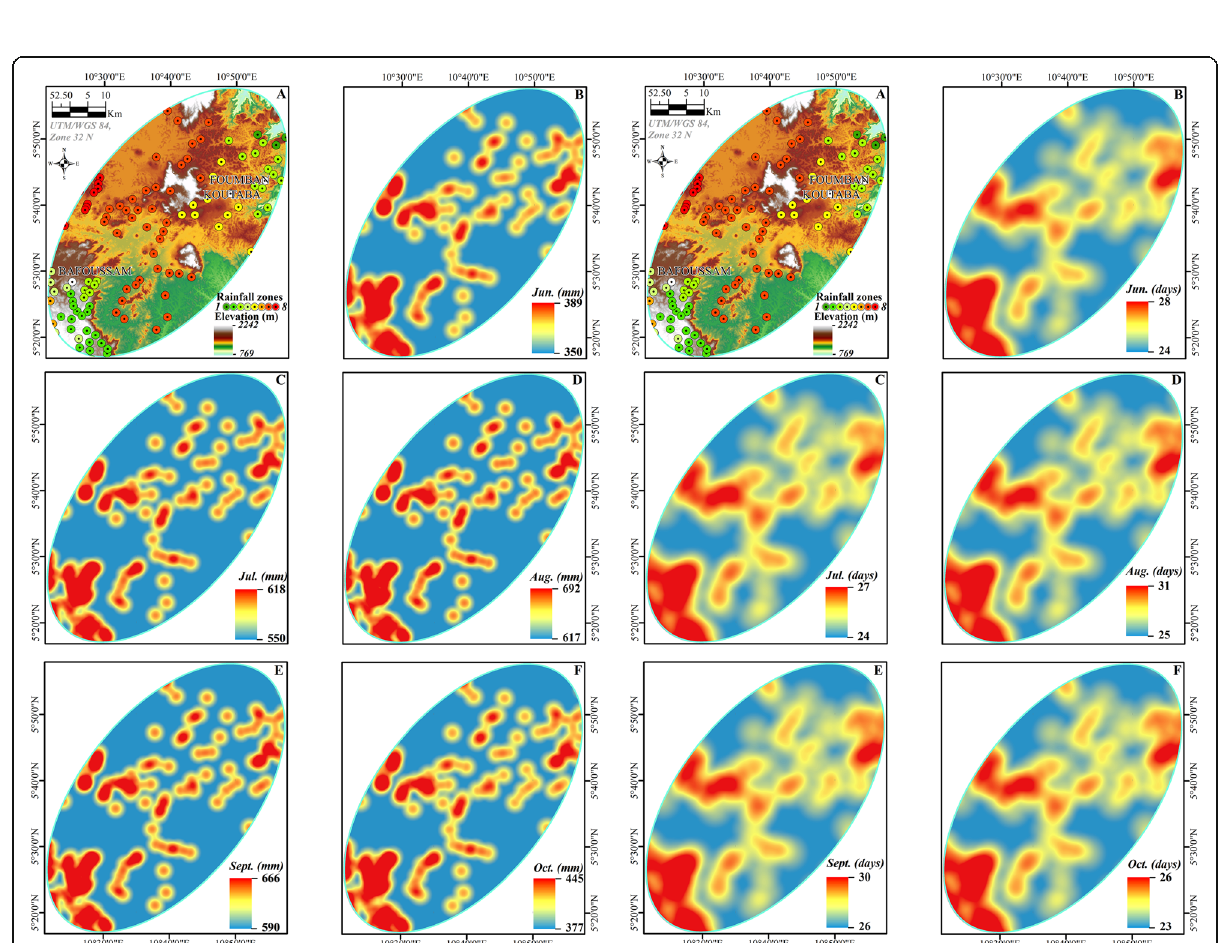
Fig. 12 Spatial distribution of daily rainfall ( left ) and days of rainfall ( right ) from June to